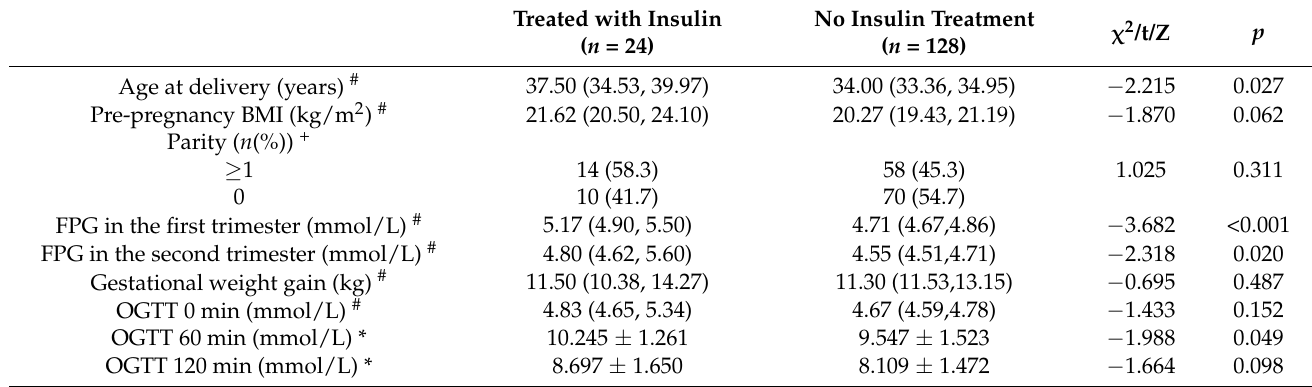
Table 4. Univariate comparison of risk factors for insulin use in CRD group.